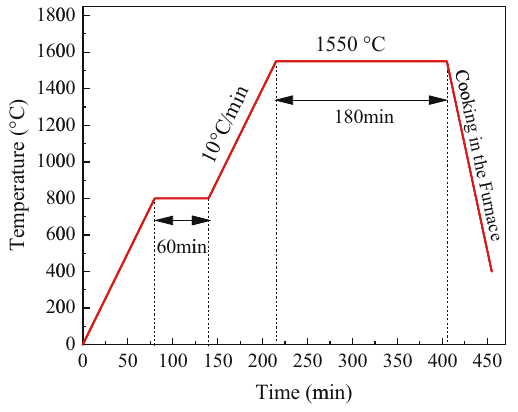
Figure 2: Heating curves of the experimental